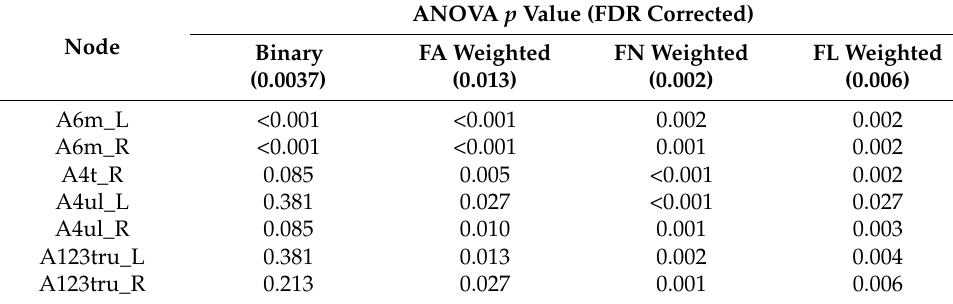
Figure 5. Nodal efficiency of A6mL and A6mR in all four weightings. Table 5. Seven nodes that exhibited degree centrality